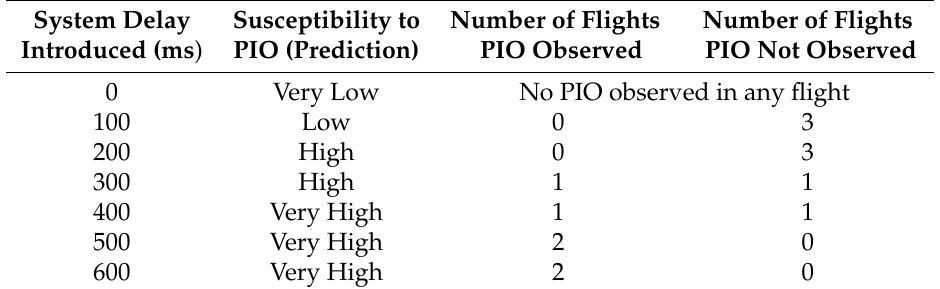
Table 1. PIO susceptibility prediction using bandwidth/pitch rate overshoot method and actual flight test